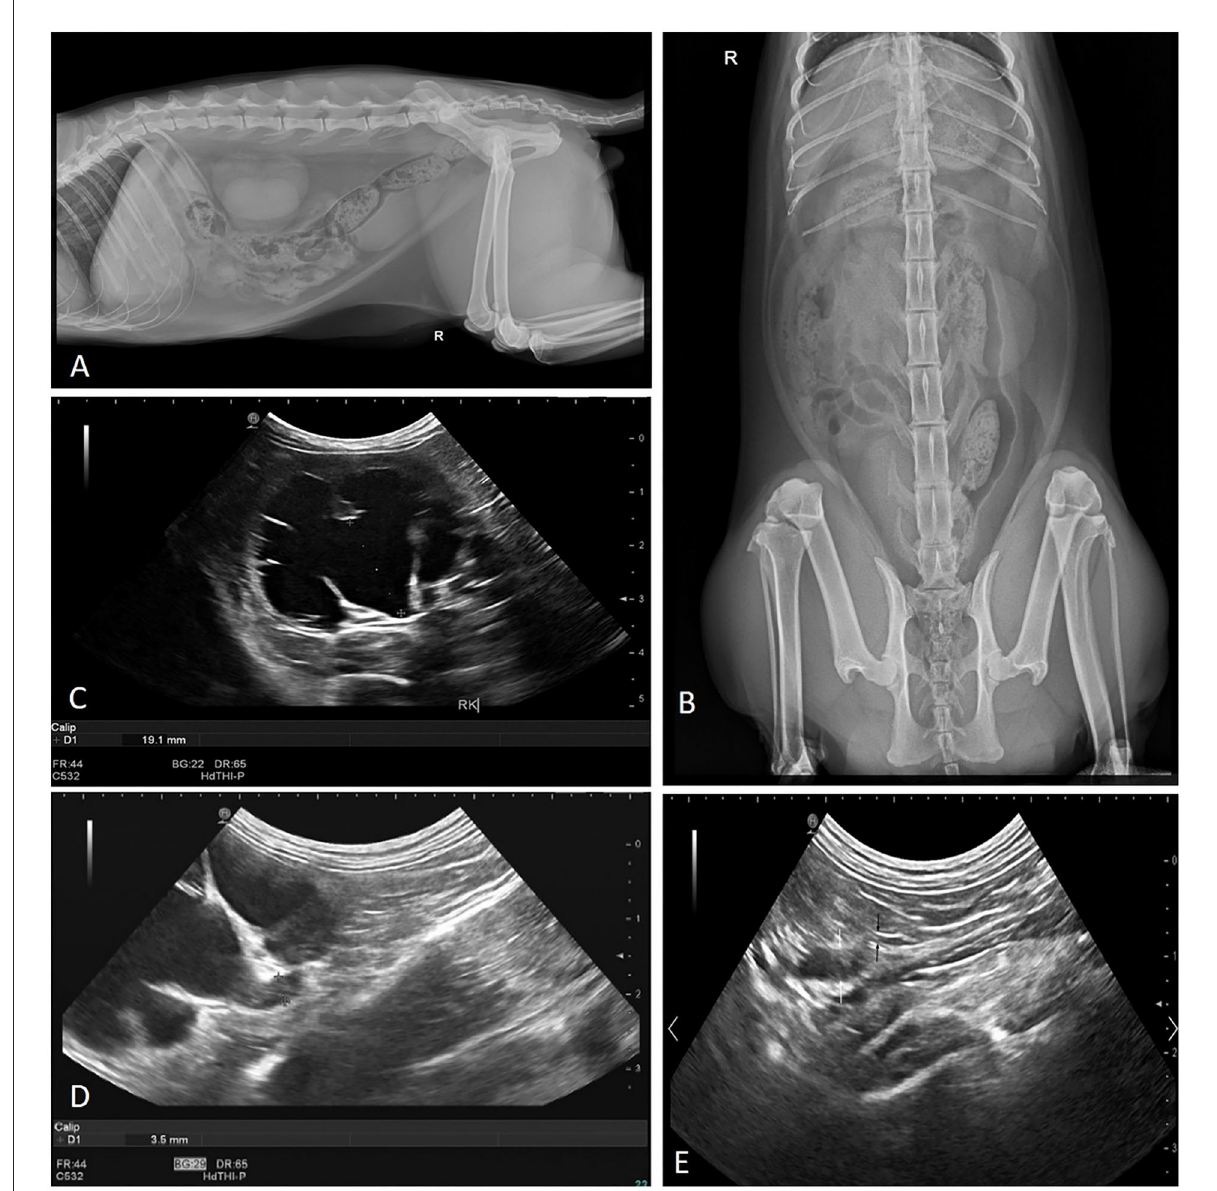
FIGURE1 Abdominal radiography and ultrasonography revealed: (A) enlarged unilateral kidney in the right lateral view, (B) a right renomegaly confirmed in ventrodorsal view, (C) transverse image of the right kidney demonstrated severe renal pelvic dilation (calipers), (D) dilatation of right proximal abdominal ureter (calipers), and (E) right proximal ureter dilatated (white arrow) and tapered abruptly (black arrow).